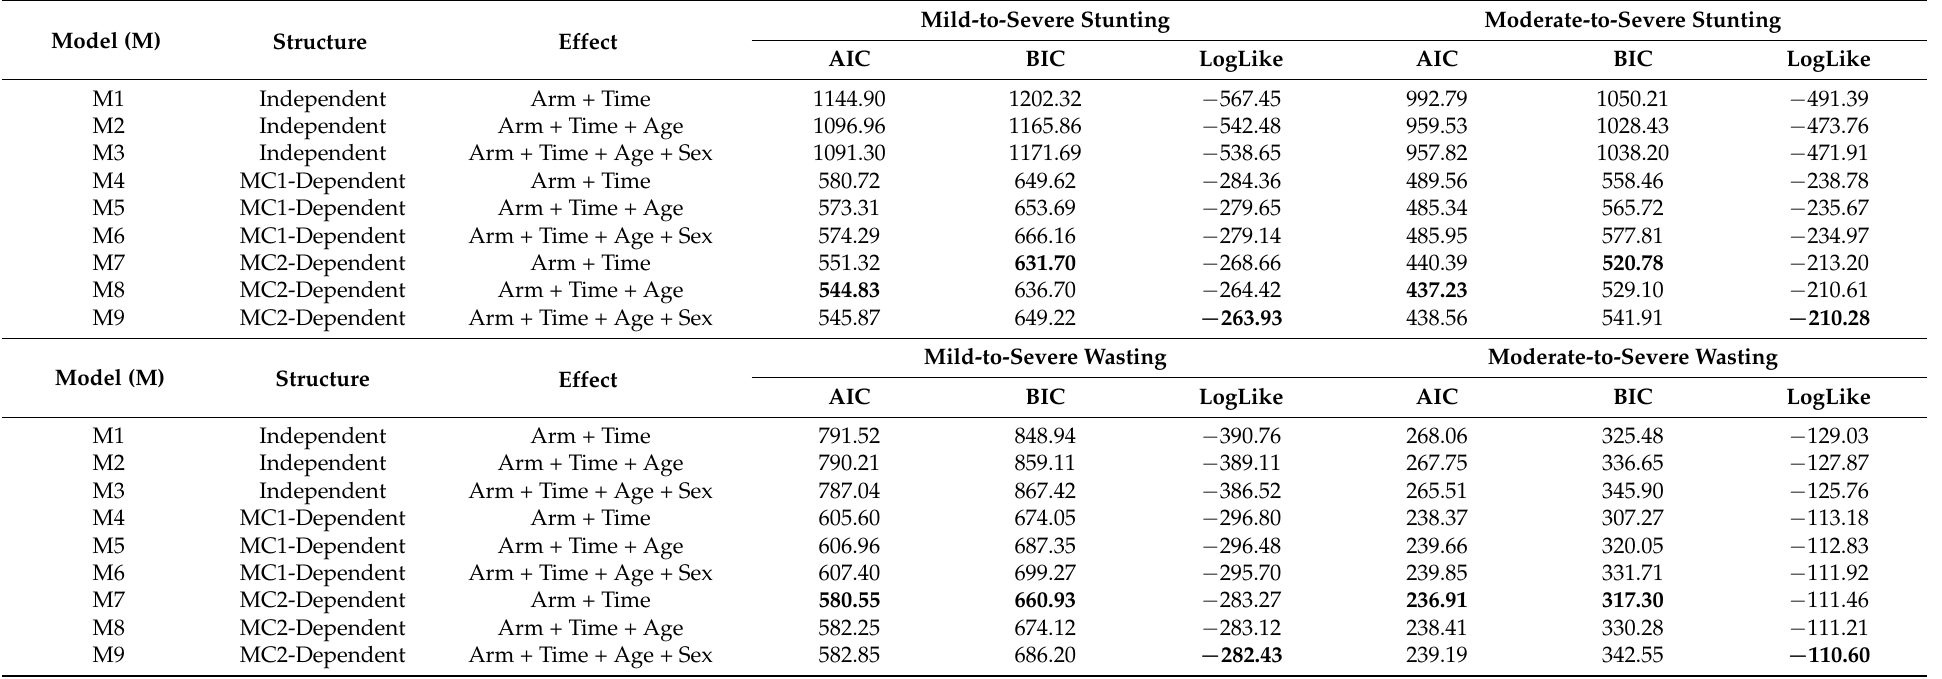
Table 3. Model comparison for binary outcomes of stunting and wasting (mild-to-severe and moderate-to-severe